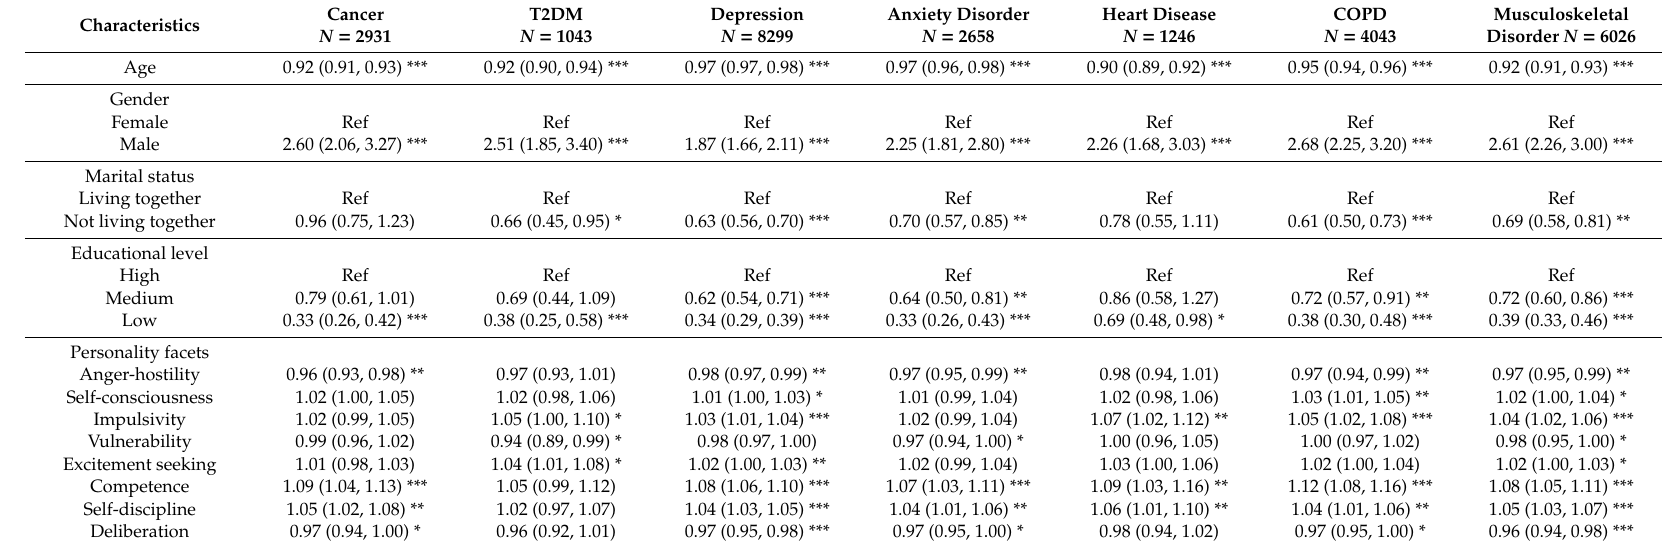
Table 4. Associations of personality facets and labor market attachment among individuals with at least one chronic health condition 1